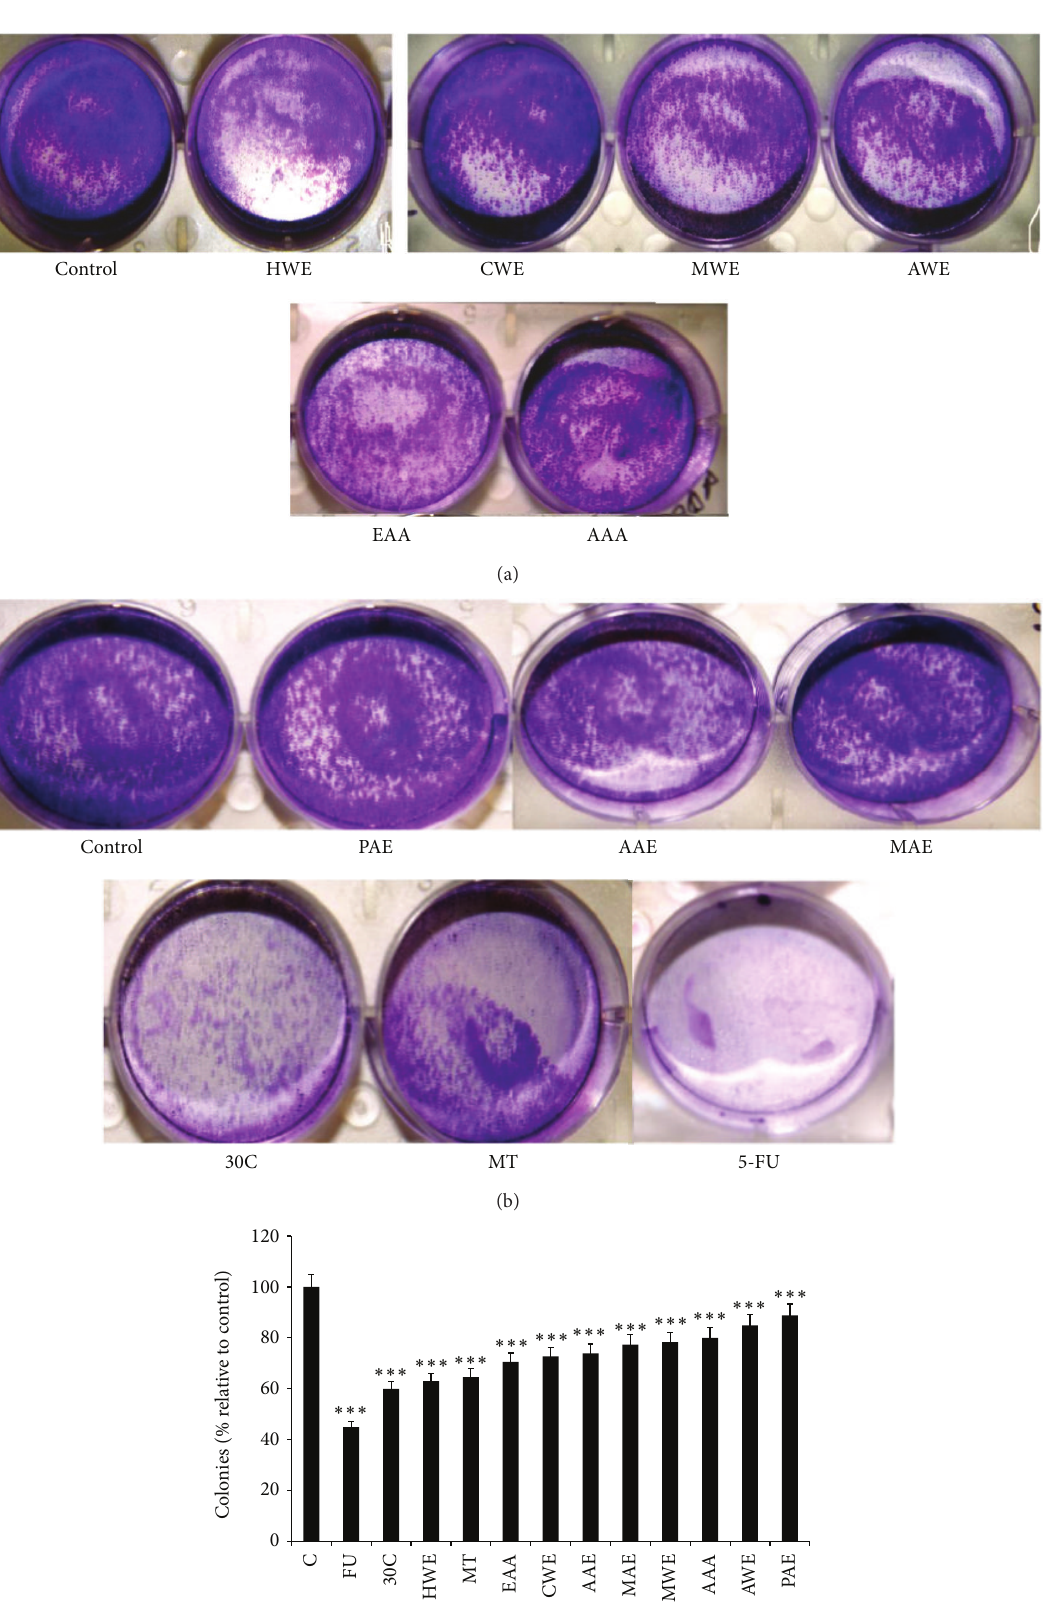
(c) Figure 3: The pictographic representation of antiproliferative effect by colony formation assay of NRK-52E cells on treatment with IC 50 values of (a) control (untreated), HWE, CWE, MWE, AWE, EAA, and AAA and (b) control (untreated), PAE, AAE, MAE, 30 C, and MT of Ruta and 5-FU for 14 days and (c) represents % percent colonies formation wrt to control